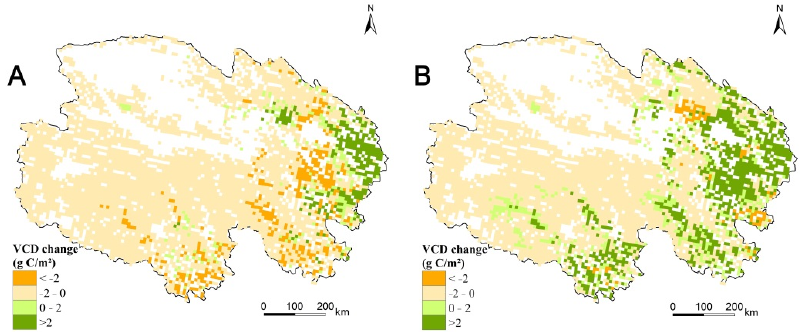
Figure 4. Vegetation carbon density (VCD) change in the Qinghai grasslands from 1979 to 2000 ( A ) and from 2001 to 2018 ( B ).